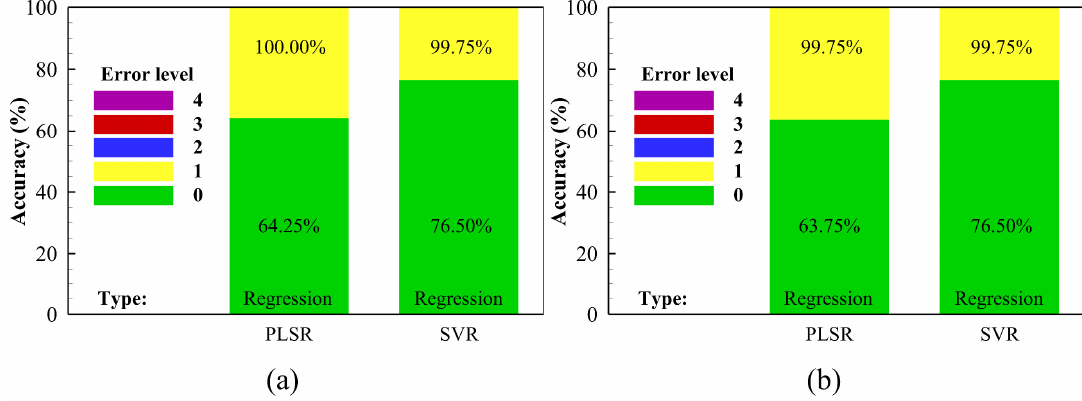
Figure 6. The accuracy and n-level-error accuracy of the regression models using ( a ) the average and ( b ) majority rule of pixel-based prediction results.